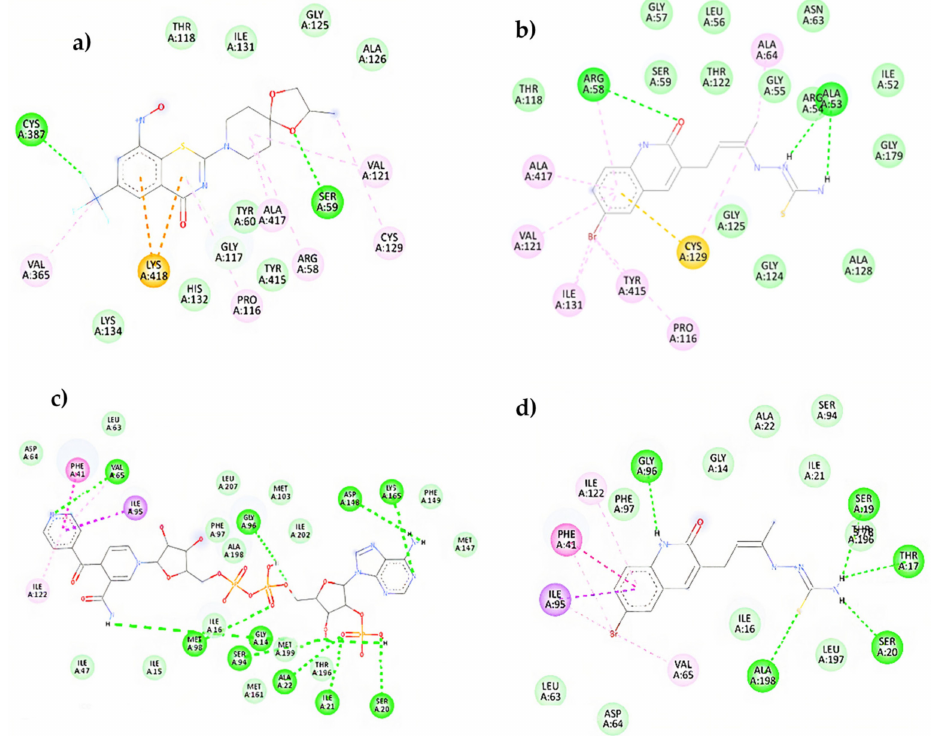
Figure 6. Two-dimensional molecular interaction diagram: ( a ) BTZ043-DprE1 complex; ( b ) 11e - DprE1; ( c ) INH-NADP-InhA complex; ( d ) 11e -InhA